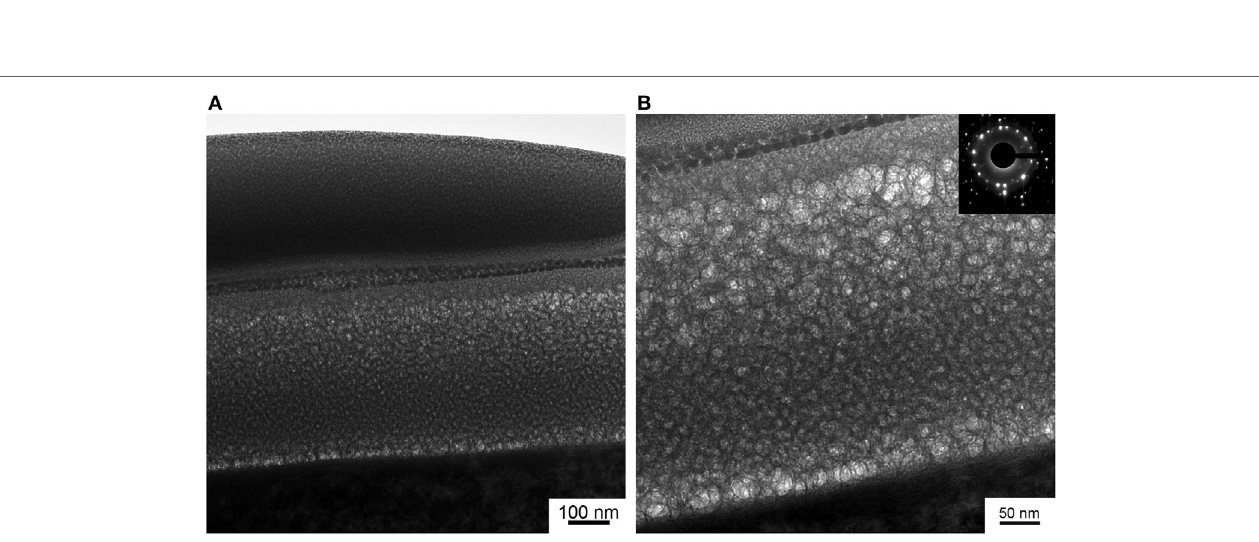
FigUre 3 | Cross-section view on the gradient HA-Zn coating under conductive and protective layers (a) and the high magnification image of HA-Zn coating with a selected area diffraction micrograph (B) .